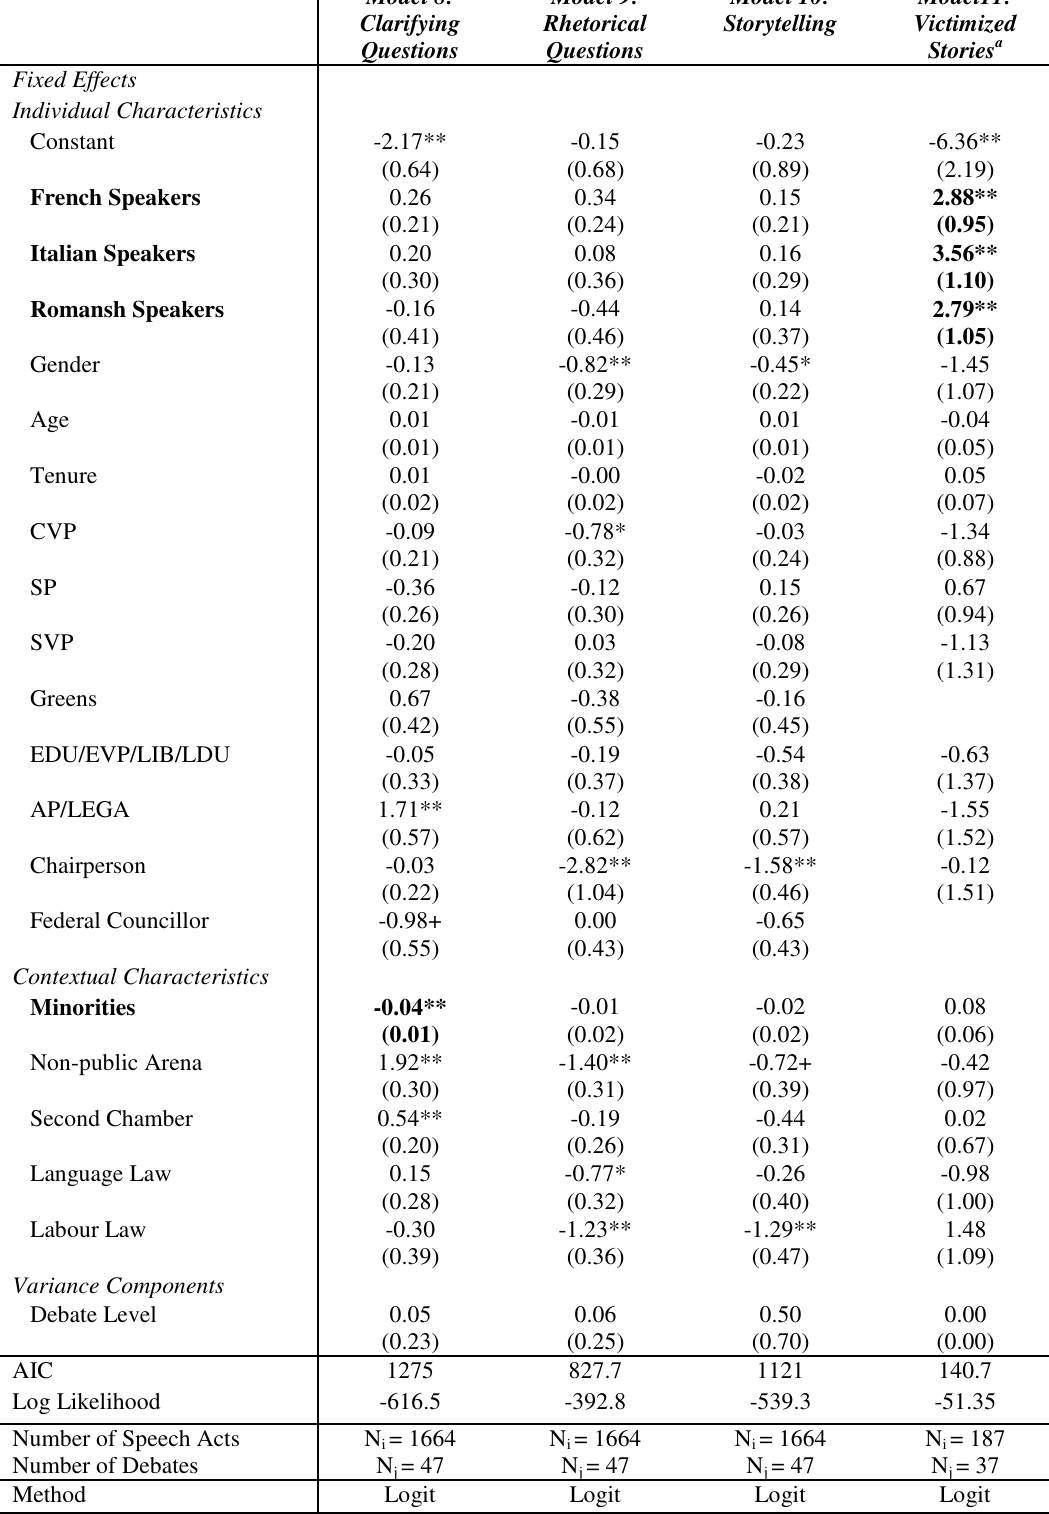
Table 5: Antecedents of Questioning and